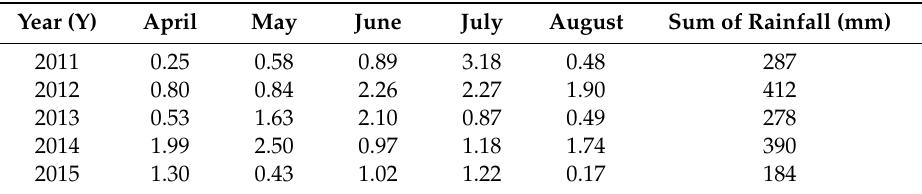
Table 1. Sielianinov index ( K ) during the narrow-leaved lupin growing season (2011–2015), recorded at the Agrometeorological Observatory in Gorzy´n,